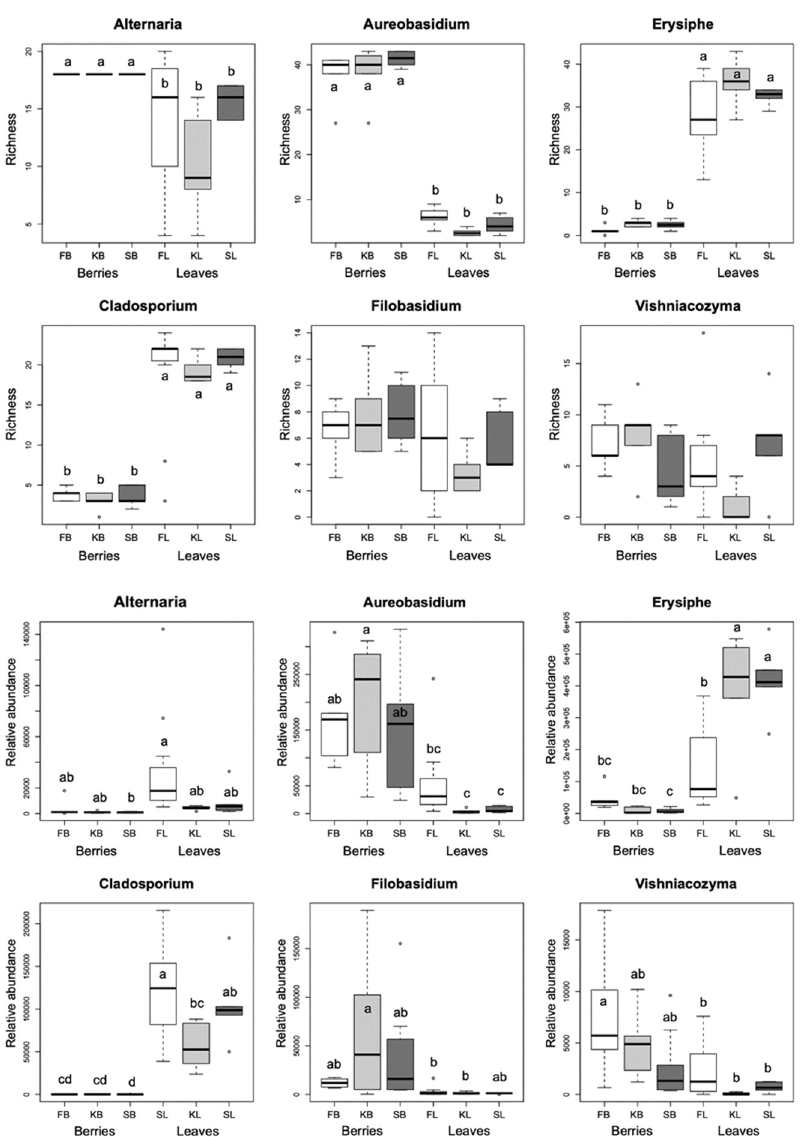
Figure 1. Boxplots showing the ASV richness and the rarefied read abundance of dominant fungal genera among all samples, based on the rarefied dataset. Means were compared using ANOVA and Tukey’s HSD tests, with letters denoting significant differences within each boxplot.